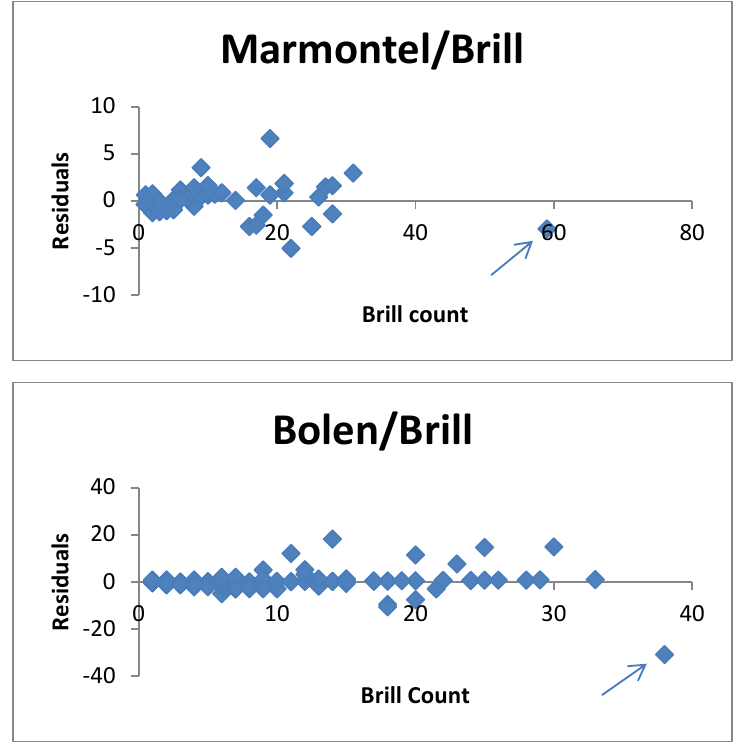
Fig. 2. Residual plots for each pair of readers with outliers identified